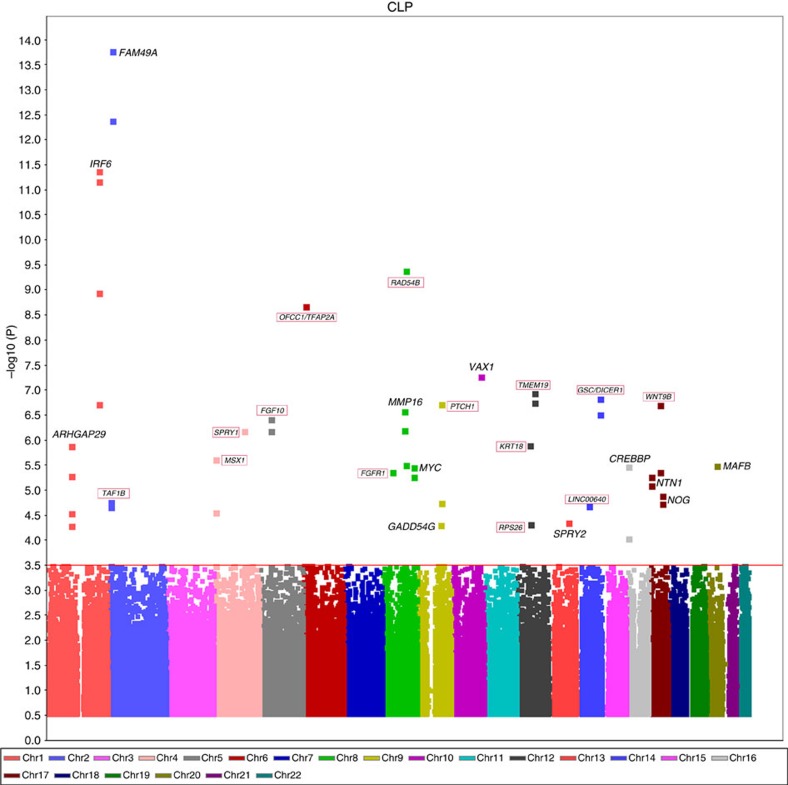
Manhattan plot of the association evidence of the 26 NSCLP risk loci in the discovery stage.Prioritized genes from the 14 novel loci are encircled with red box, the remaining candidate genes are from the 12 previously reported loci.